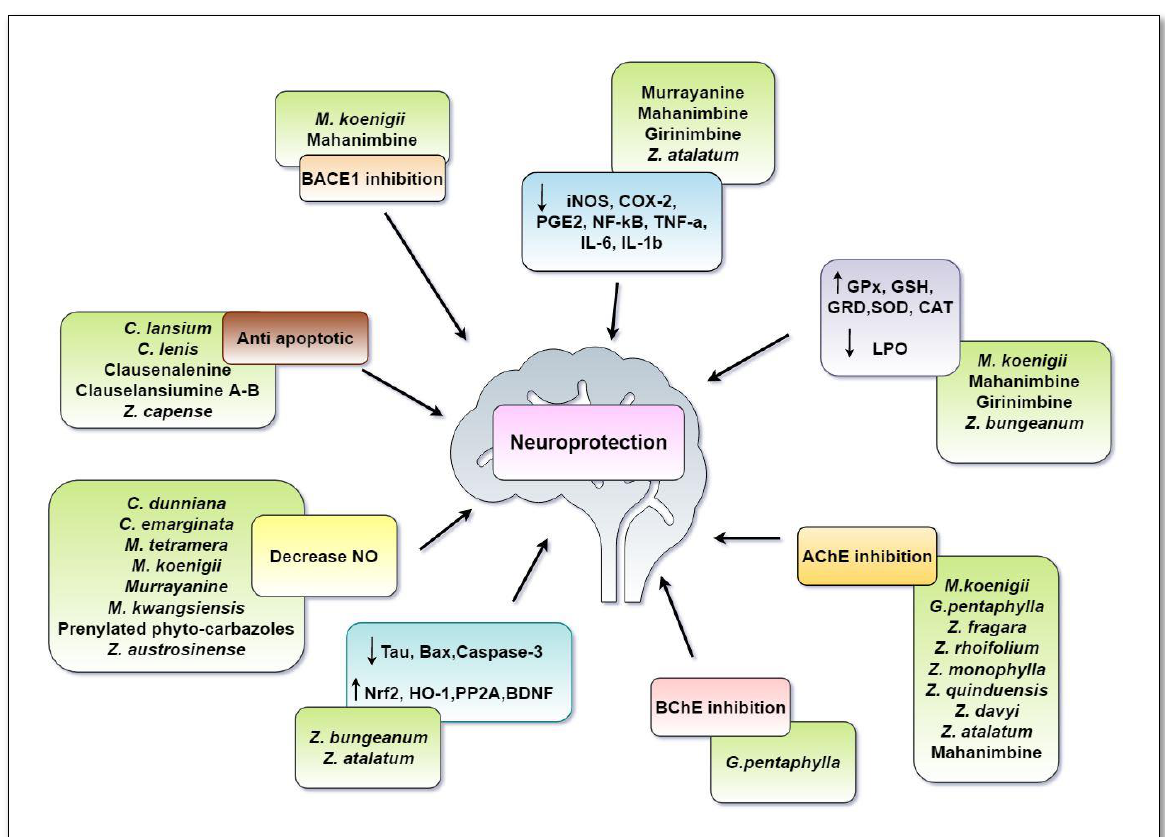
Figure 7. Multi-target mechanism displayed by Rutaceae family plant extracts and carbazole alkaloids in neurodegenerative diseases. Phyto extracts and carbazole alkaloids from Rutaceae family exerted a multi-target approach in ameliorating symptoms of AD. PP2A and BDNF activity/expression was decreased in AD , which stimulated the hyper-phosphorylation of Tau and APP, leading to overproduction of Aβ. Phyto-carbazoles prevented Aβ aggregation by inhibiting cleavage of the APP by BACE-I, as well as by upregulating the expression of PP2A and BDNF. This caused a shift in the non-amyloidogenic pathway and reduced the levels of produced Aβ. A number of phyto-carbazoles were shown to reduce the levels of pro-inflammatory cytokines and inflammatory mediators (IL-6, IL-1β, NF-kβ, TNF-α, iNOS, COX-2). Nrf2/HO-1 was an antioxidant signaling pathway, which was required for neuronal cell proliferation and survival. Down-regulation of this pathway was associated with various NDs. Phyto-carbazoles provided the neuroprotection by upregulating the expressions of the Nrf2/OH-1 pathway. They also reduced the oxidative stress by increasing the levels of antioxidant enzymes (SOD, CAT, GSH, GRD, GPx) and reducing lipid peroxidation (LPO). Caspase-3 and Bax were responsible for neuronal death and were up-regulated in AD. Phyto-carbazoles down-regulated their expressions and prevented apoptosis. ACh, a neurotransmitter essential for processing memory and learning, was decreased in both concentration and function in AD. Decreased levels of ACh could be restored by the AChE and BChE inhibitory activity of phyto-carbazole alkaloids. Overproduction of NO was linked to neuroinflammation, mitochondrial dysfunction and neurotoxicity in NDs. The increased levels of NO were also controlled by phyto-carbazole and plant extracts from the